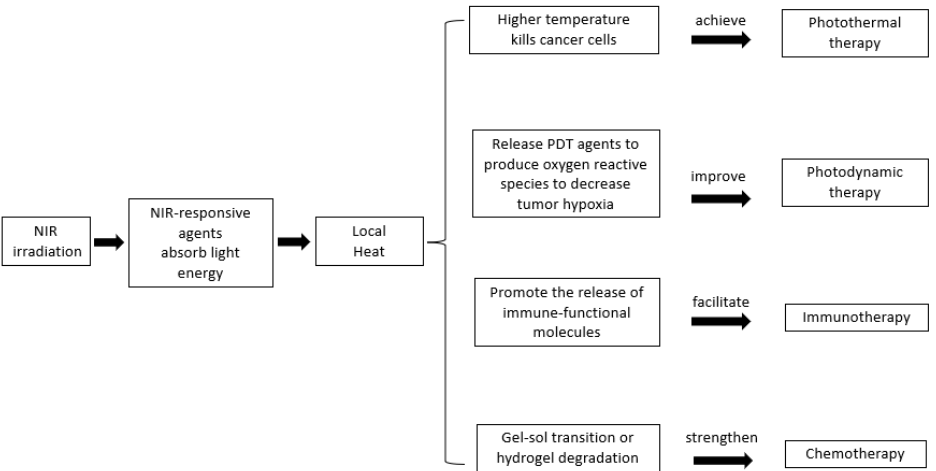
Figure 3. Combinational breast cancer therapies are enabled by embracing NIR-responsive materi- als into the injectable hydrogel system to enhance treatment efficacy and increase cancer-killing ef-